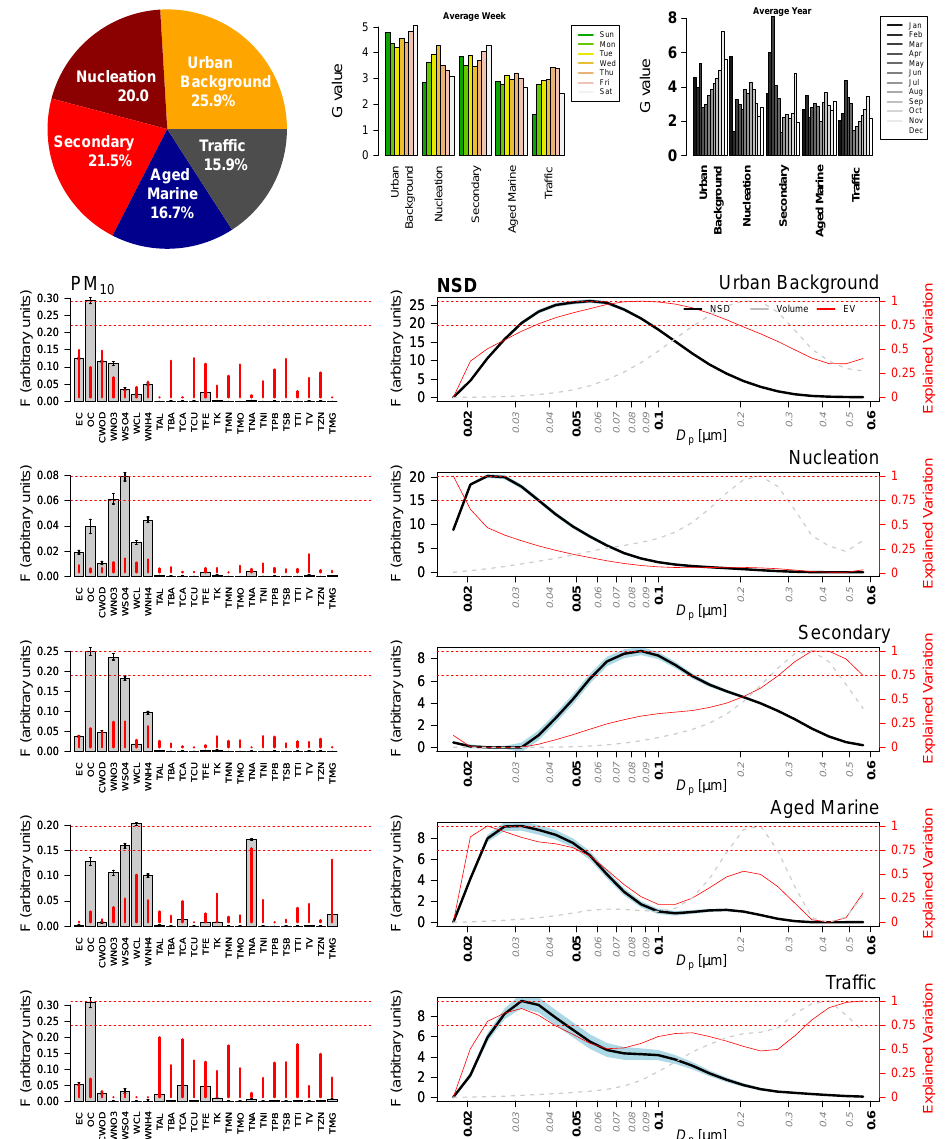
Figure 3. Five-factor solution from the combined composition–NSD data set showing the contribution (black line) and explained variation of each metric (red